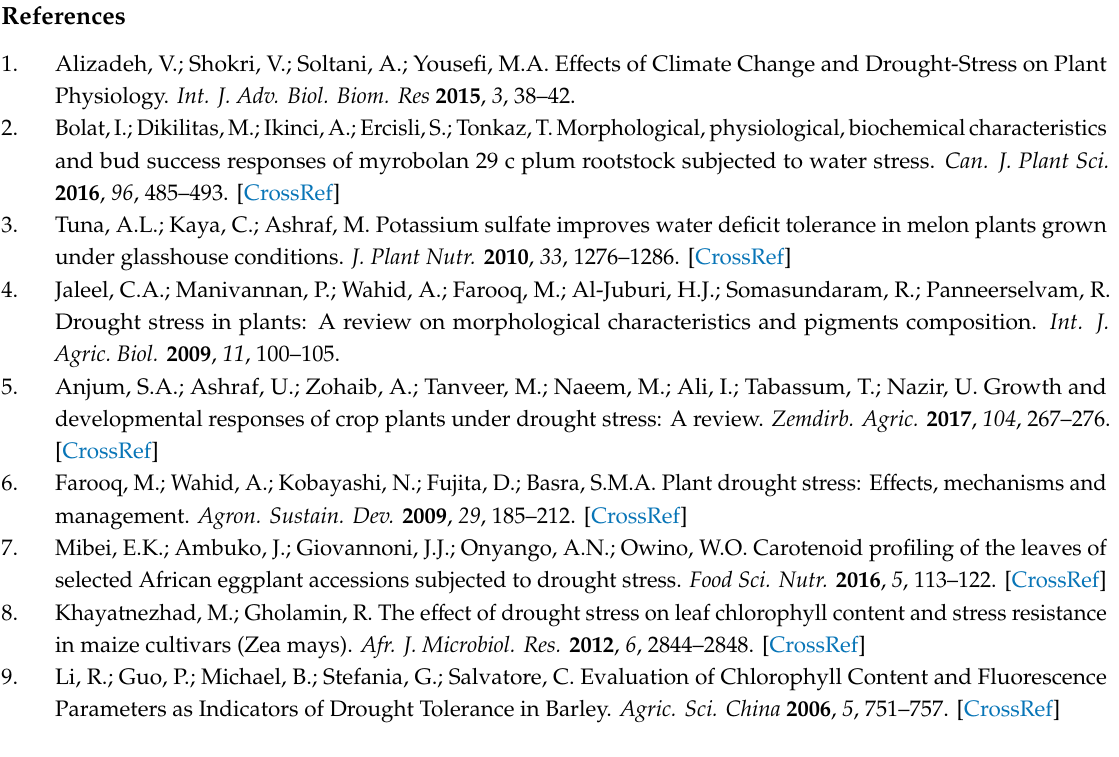
Supplementary Materials: The following are available online at http: // www.mdpi.com / 2073-4395 / 10 / 11 / 1689 / s1, Table S1: E ff ect of di ff erent concentration of PEG-6000 on fresh weight, dry weight, water content, and leaf area of in vitro culture of apple cultivars. Data are means ± SD (n = 3). Values within column, followed by the same letter(s), are not significantly di ff erent according to Tukey’s test ( p < 0.05)., Table S2: E ff ect of di ff erent concentration of PEG-6000 on fresh weight, dry weight, water content, and leaf area of in vitro culture of cherry cultivars. Data are means ± SD (n = 3). Results of statistic are the same as in Table S1, Table S3: E ff ect of PEG-6000 concentration on chlorophylls and total carotenoids contents in in vitro culture of apple cultivars. Data are means ± SDs (n = 3). Results of statistic are the same as in Table S1, Table S4: E ff ect of PEG-6000 concentration of on chlorophylls and total carotenoids contents in in vitro culture of cherry cultivars. Data are means ± SDs (n = 3). Results of statistic are the same as in Table